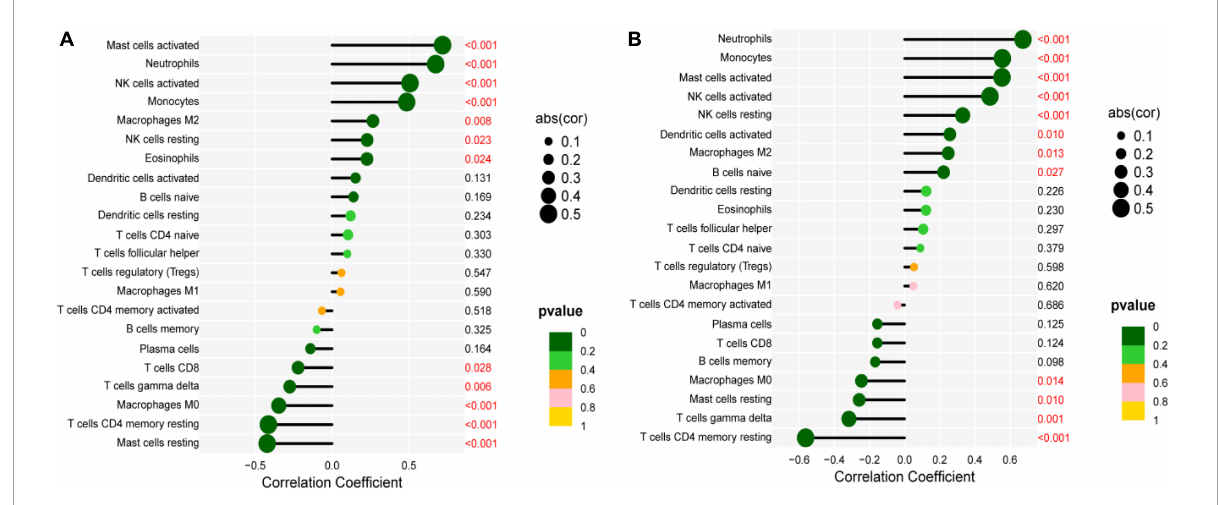
FIGURE9 Correlation between IL1B, TLR2, and infiltrating immune cells. (A) Correlation between IL1B and infiltrating immune cells. (B) Correlation between TLR2 and infiltrating immune